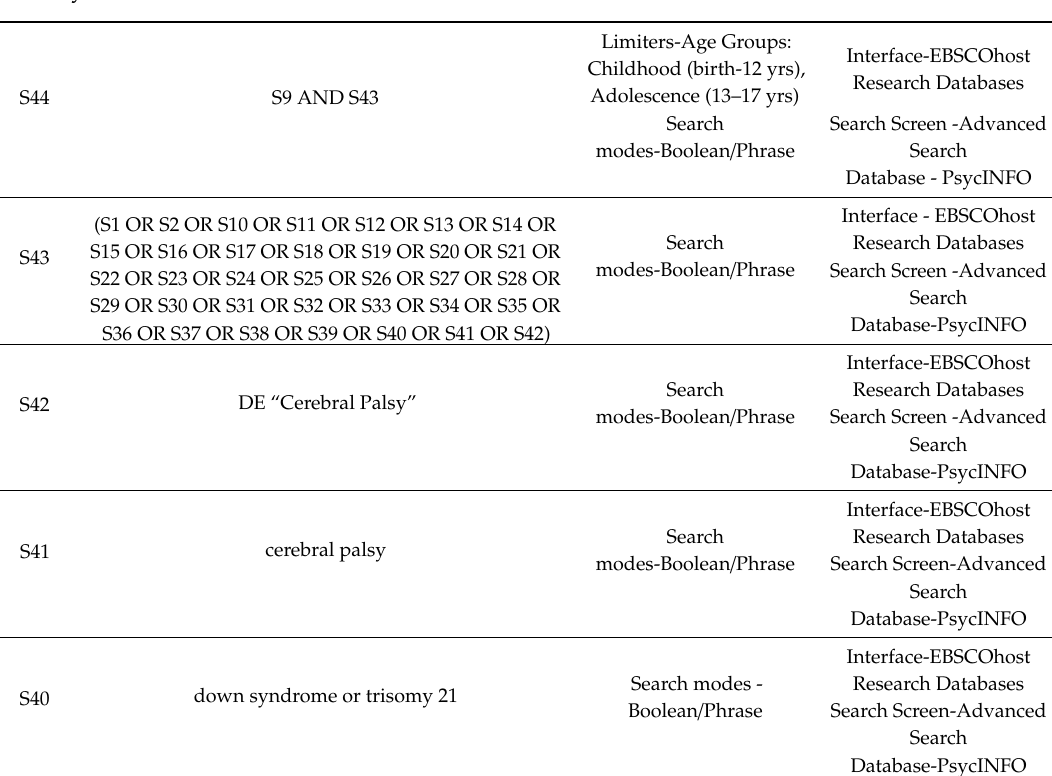
heading word, floating sub-heading word, keyword heading word, organism supplementary concept word, protocol supplementary concept word, rare disease supplementary concept word, unique identifier, synonyms]